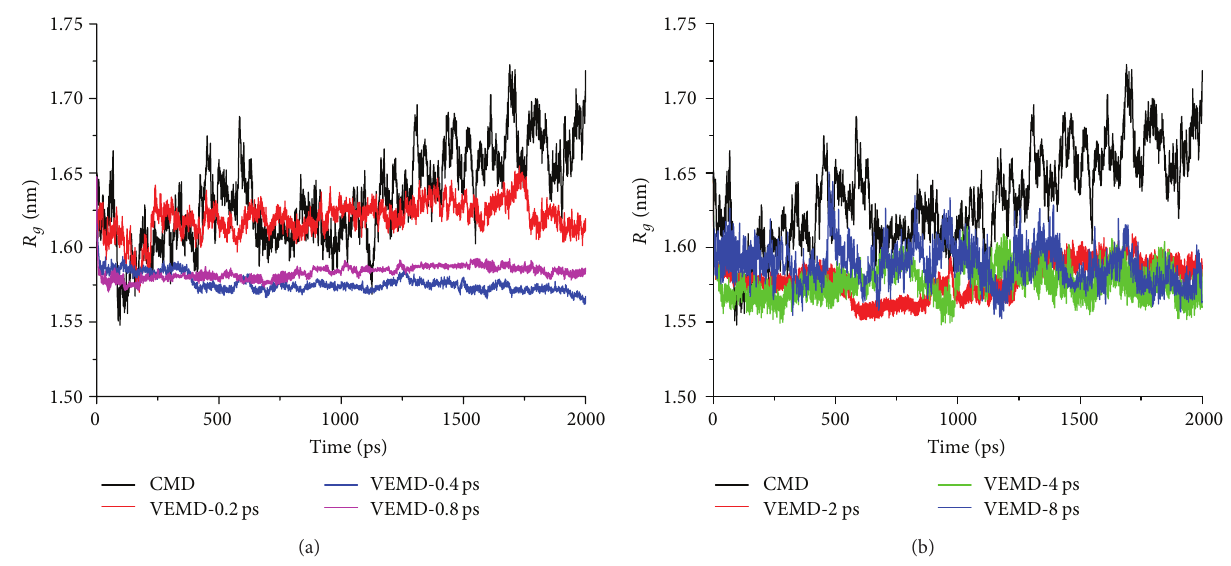
Figure 10: Radius of gyration curves of the CMD and VEMD